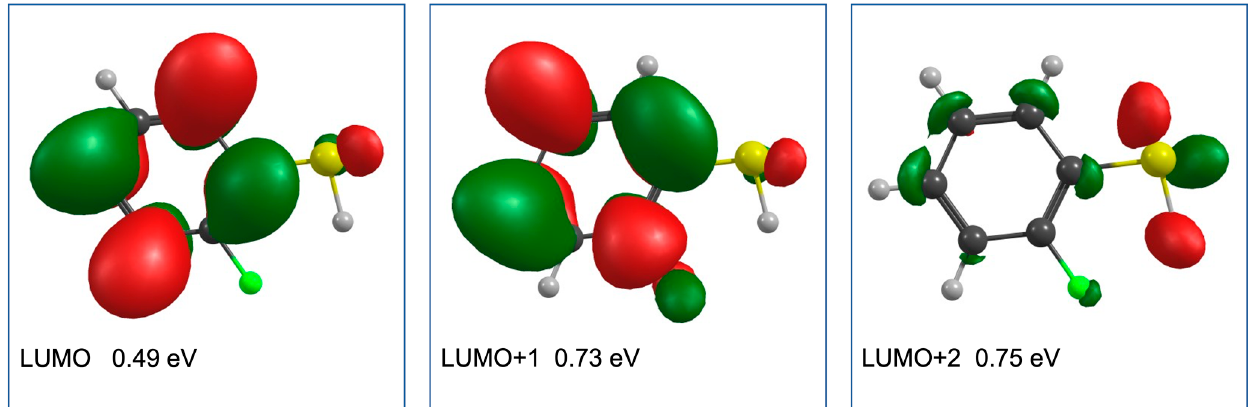
Figure 8. Contour plots of the LUMO, LUMO + 1, and LUMO + 2 of PFTP (B3LYP orbitals). The respective vertical electron attachment energy calculated using the EOM-EA-CCSD method with the B3LYP orbitals and aug-cc-pVTZ basis set are shown for each orbital. The LUMO and LUMO + 1 have a π * character and correlate with a 2 ( π * ) and b 1 ( π *) MOs, respectively, while LUMO + 2 is a partial diffuse orbital with some electron density on the S and H atoms.